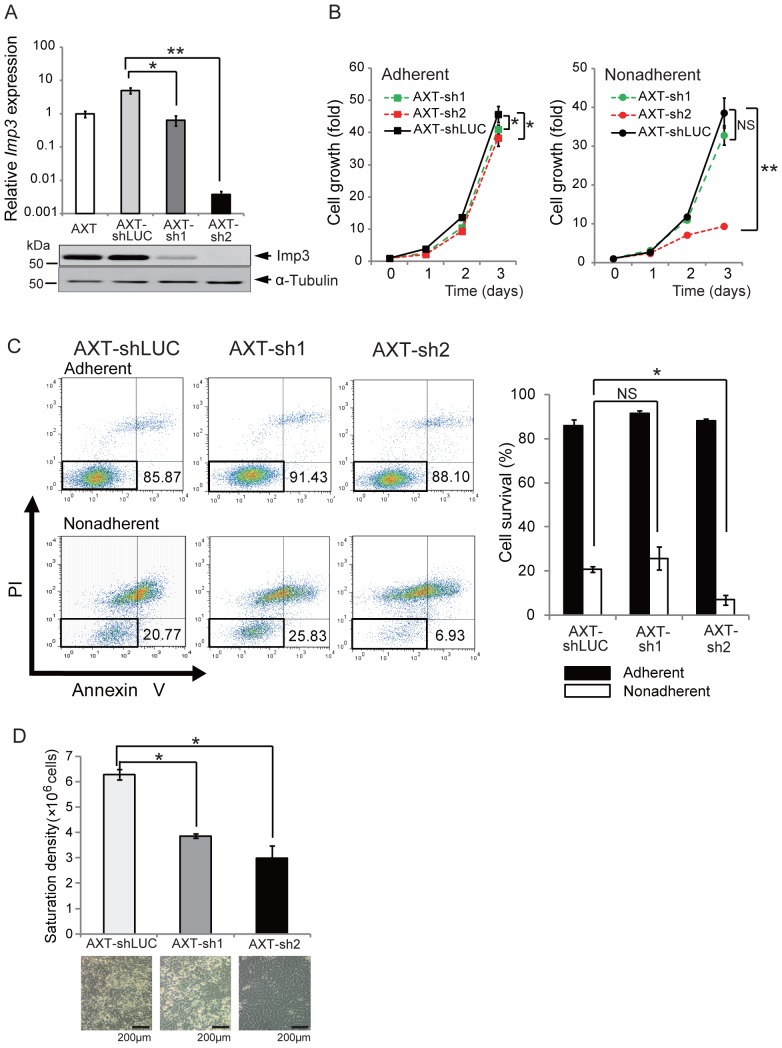
Knockdown of Imp3 in AXT cells attenuates malignant cellular phenotype.(A) The efficacy of knockdown of Imp3 in AXT cells was evaluated by real-time PCR analyses and immunoblotting. *P<0.01, **P<0.001. (B) Cell proliferation assays for AXT-shLUC, AXT-sh1, and AXT-sh2 cells cultured under adherent or nonadherent conditions. *P<0.05, **P<0.001. NS, not significant. (C) AXT-shLUC, AXT-sh1, and AXT-sh2 cells were cultured under adherent (upper panels) or nonadherent (lower panels) conditions for 24 h and were then stained with annexin V and PI. The percentages of viable (annexin V– and PI-negative) cells are indicated for a representative experiment. The percentage of viable cells was determined as means ± SD for three independent experiments. *P<0.01. NS, not significant. (D) AXT-shLUC, AXT-sh1, and AXT-sh2 cells were cultured under normal conditions for 3 days, after which the saturation density was determined by counting total cell number. *P<0.01. Representative bright-field images of cells after culture for 3 days are also shown.